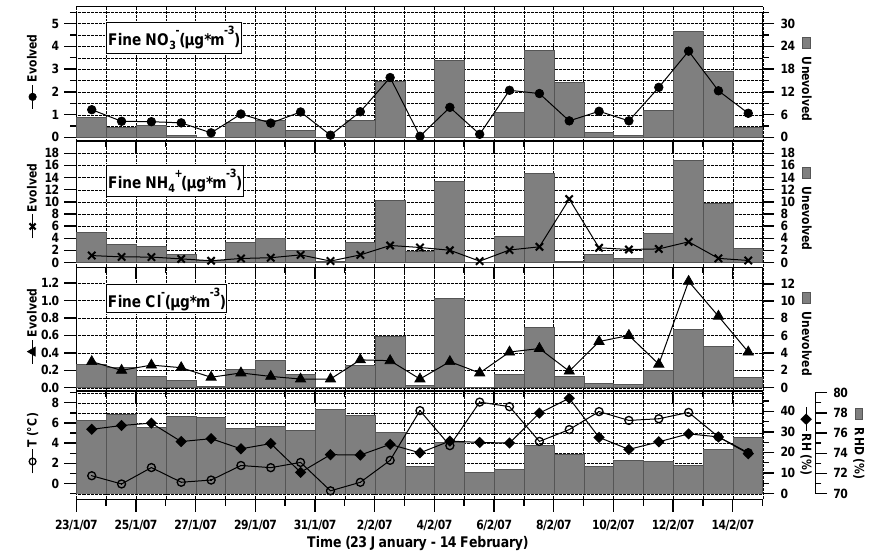
Fig. 3. Temporal trends of temperature ( T ) , relative humidity (RH), deliquescent relative humidity (RHD), and evolved and unevolved fine ) , sulphate (SO 2 − ) , nitrate (NO − ) and chloride (Cl − ) during the winter measurements, carried out on a 24-h particulate ammonium (NH + 4 4 3 basis, at Beijing.